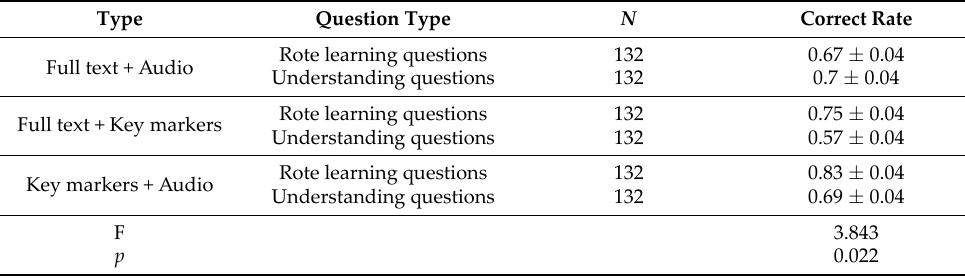
Table 7. Descriptive statistics for display mode and question type.